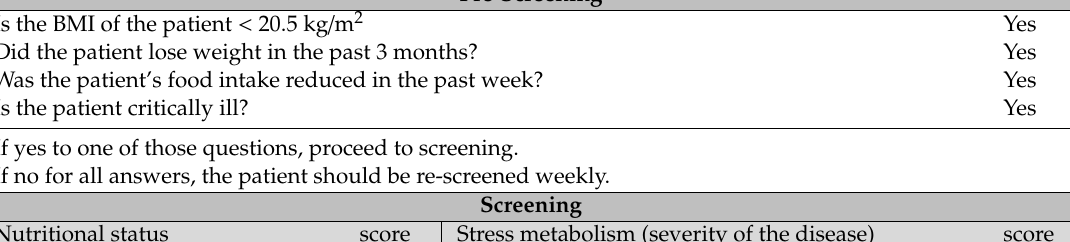
Table 1. Nutritional Risk Screening 2002. APACHE: acute physiology and chronic health evaluation; BMI:bodymassindex; COPD:chronicobstructivepulmonarydisease; ONS:oralnutritionalsupplement.